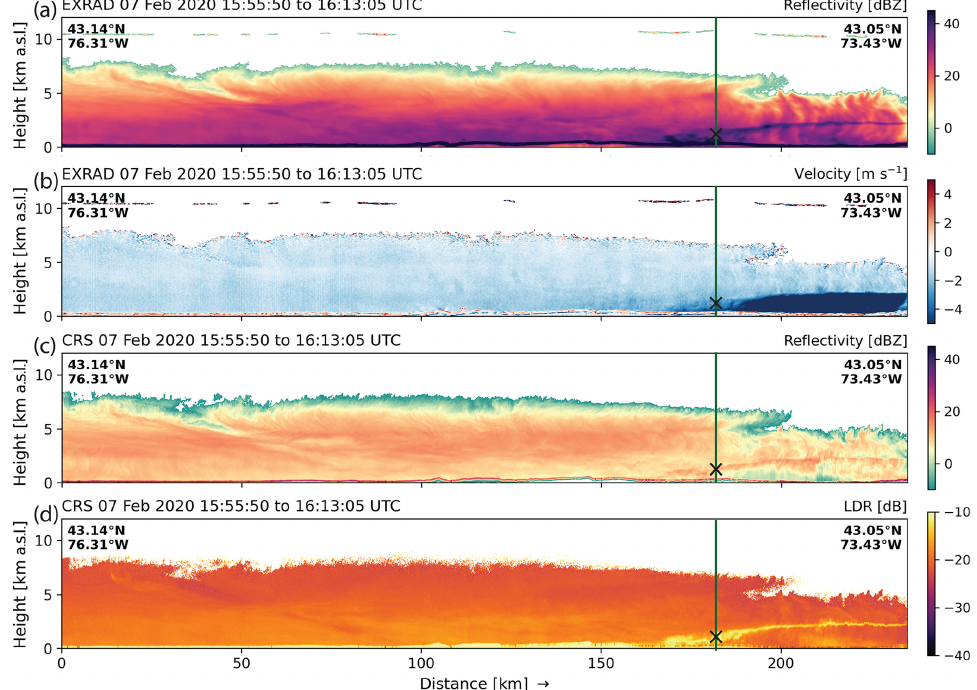
Figure 3. Vertical cross-sections of (a) reflectivity and (b) vertical velocity from the NASA ER-2 EXRAD radar and (c) reflectivity and (d) linear depolarization ratio (LDR) from the NASA ER-2 CRS radar coincident with the vertical cross-section in Fig. 2. Green line indicates current aircraft location and black X indicates the height of the point in Fig. 2a that varies along the 0.5 ◦ elevation angle scans used to construct the regional maps.